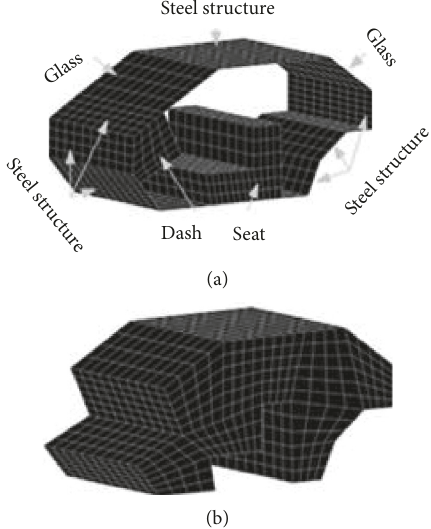
Figure 13: Structure-acoustic hybrid model validation example: (a) FEA model of the solid structure; (b) FEA model of the acoustic fluid.